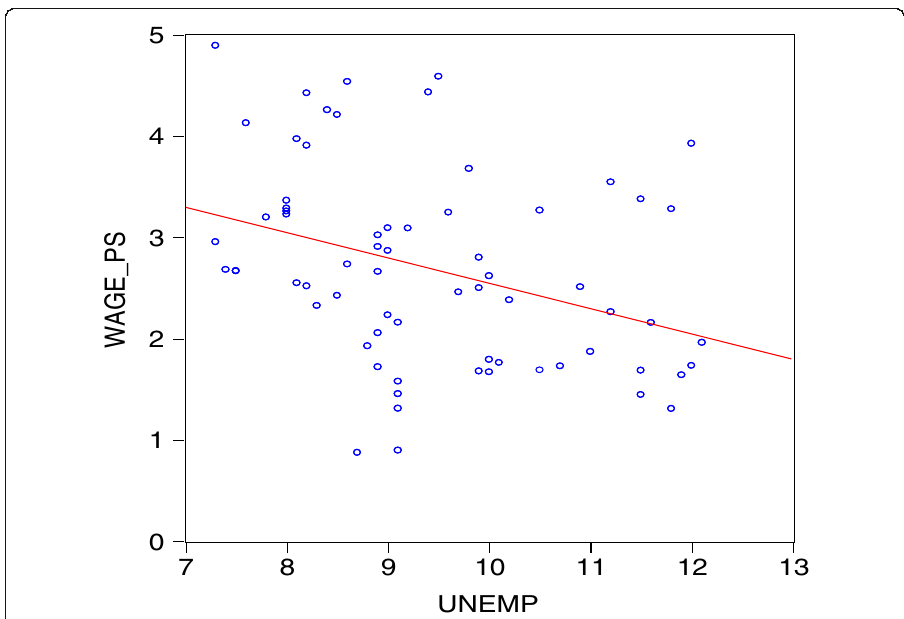
Fig. 1 Euro area, 19 countries. Nominal wage growth and unemployment